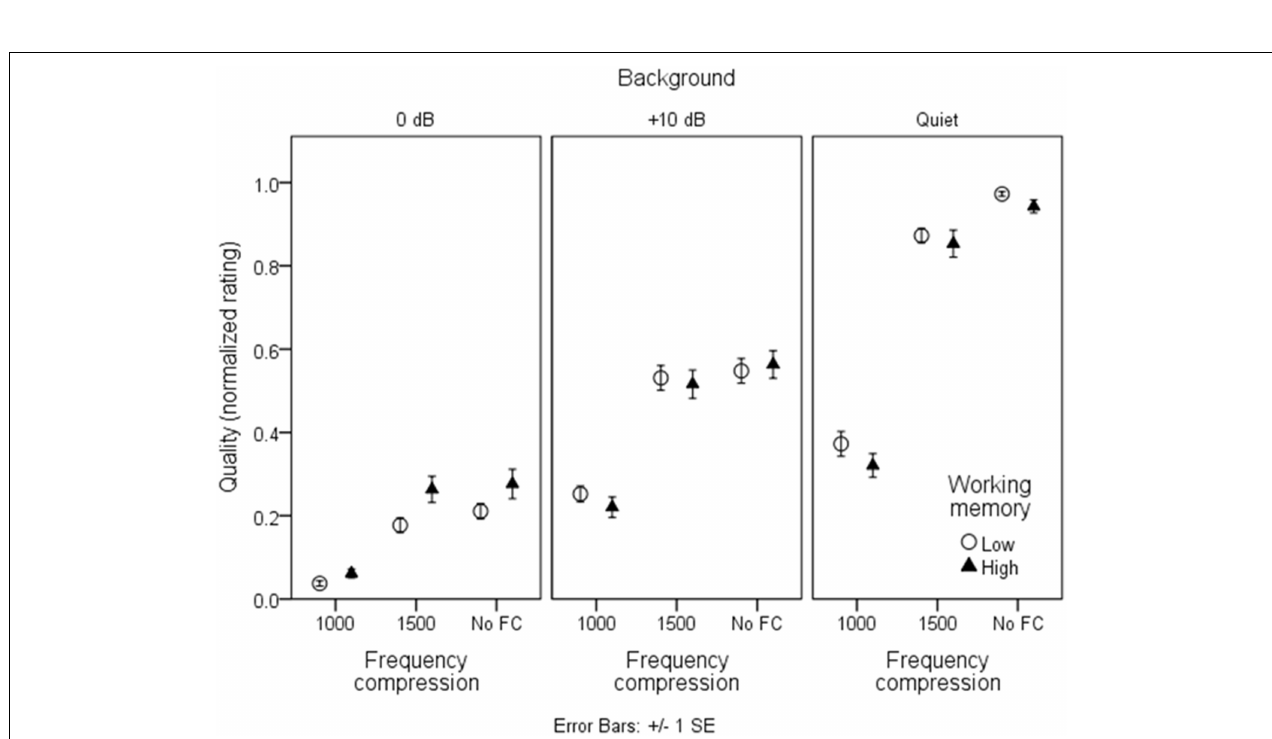
FIGURE 7 | As in Figure 3, but for quality ratings grouped by WDRC condition.